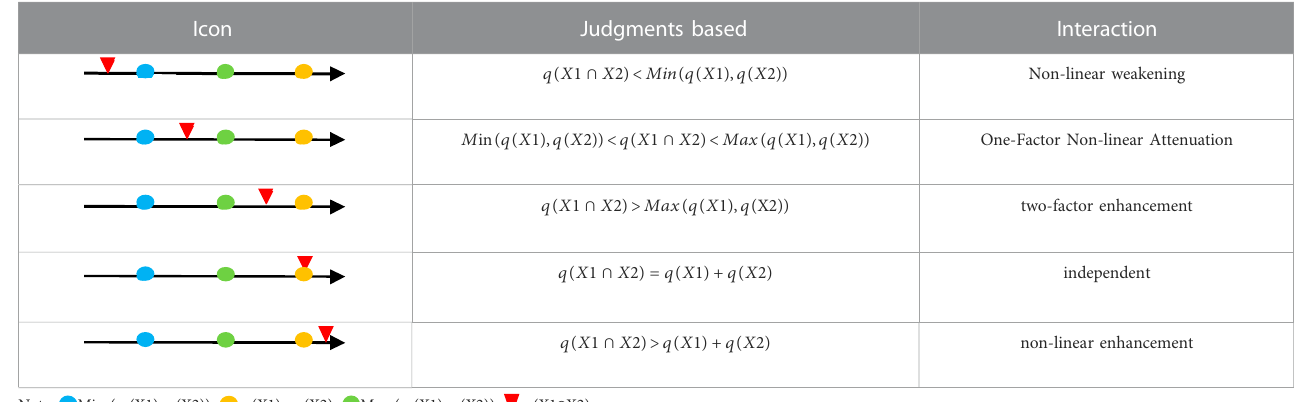
TABLE 3 Types of the interaction of two independent variables corresponding to